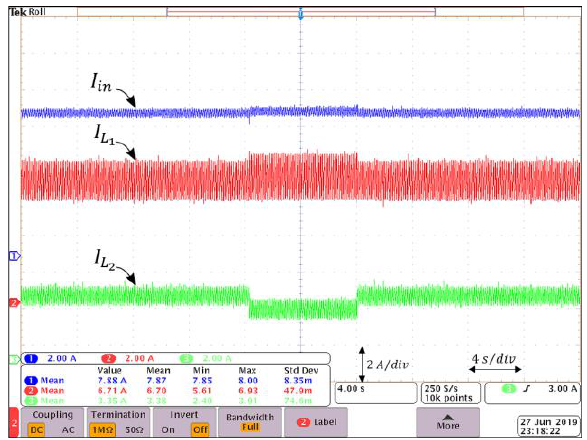
Figure 15. Dynamic compensation of the input current under load variations.